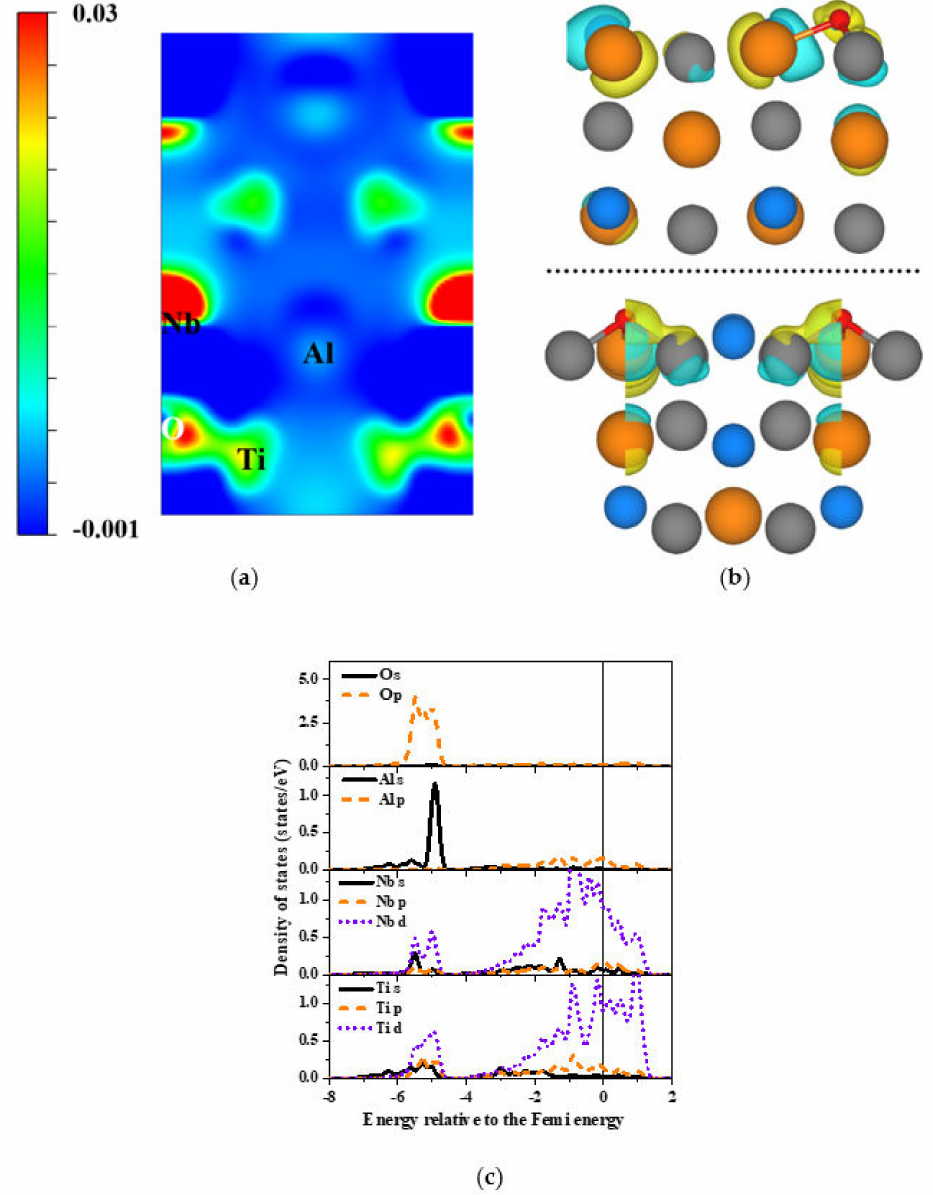
Figure 2. ( a ) charge densities, ( b ) charge difference distributions (side views), and ( c ) densities of states of oxygen adsorbed on the hcp site, red, blue, orange, and gray balls denote O, Al, Nb, and Ti atoms, respectively, blue isosurface stands for loss of electrons and yellow isosurface stands for capturing